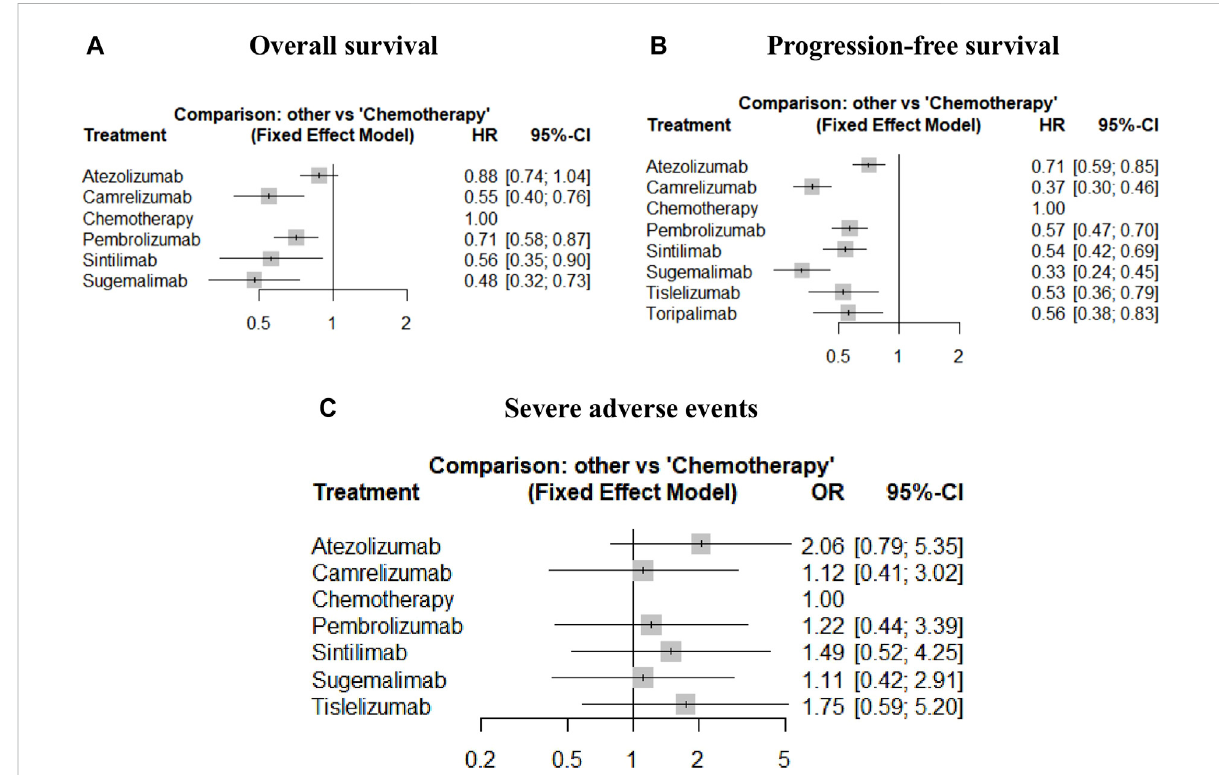
FIGURE 4 Forest plots of relative effect for overall survival (A) , progression-free survival (B) and severe adverse events (C)